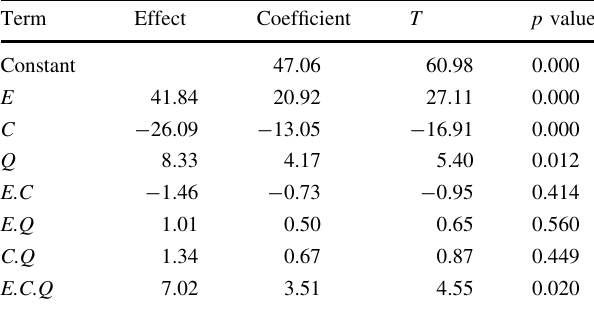
Table 5 Estimated effects and coefficients for DR (coded units)